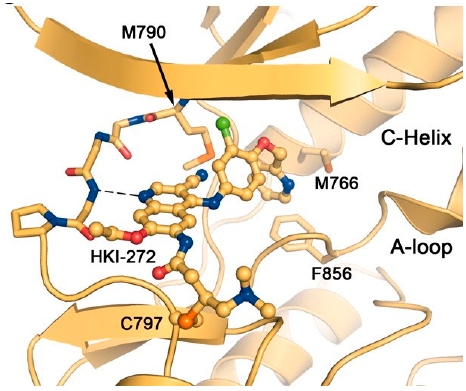
Figure 19. EGFR/T290M mutant kinase domain (PDB id: 2JIV) in complex with neratinib